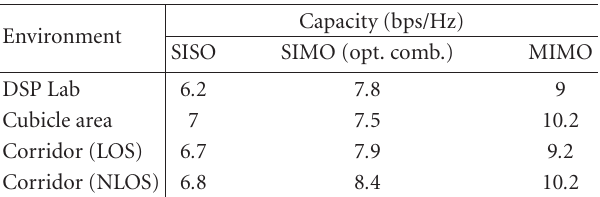
Table 2: Comparison of measured capacity for SISO, SIMO, and MIMO